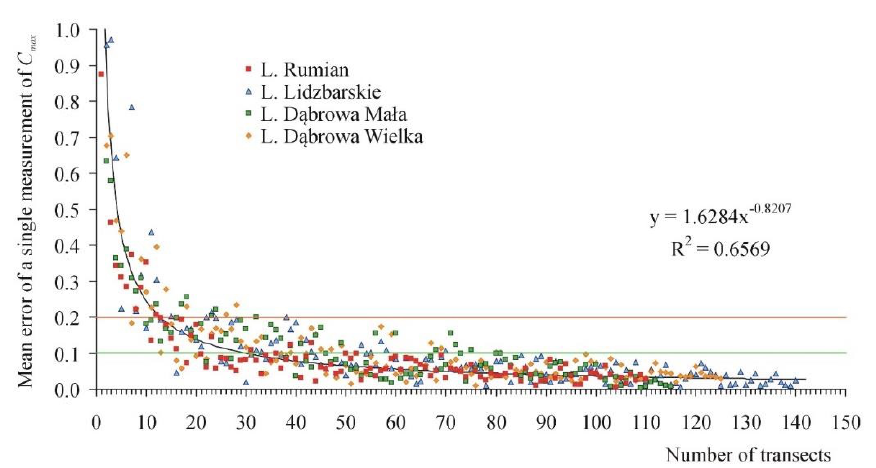
Figure 2. Relationships between the number of transects in maps and the relative error of the mean error of a single measurement of maximum macrophyte depth ( C max ) in for lakes in the Wel Landscape Park. The green line indicates an error of 0.1 m. The orange line indicates an error of 0.2 m.